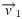
Effects of 10 Hz (black), 20 Hz (blue) and 30 Hz (grey) stimulation frequencies.A) Excitatory (v→1 and v→2) and suppressive (v→3) components for a cell stimulated at three frequencies. Note that all components occurred at lag zero. B) Excitatory (v→1) and suppressive (v→2 and v→3) components for another cell stimulated at three frequencies. In all plots, stars denote electrode amplitudes that significantly affected the neuron’s responses.